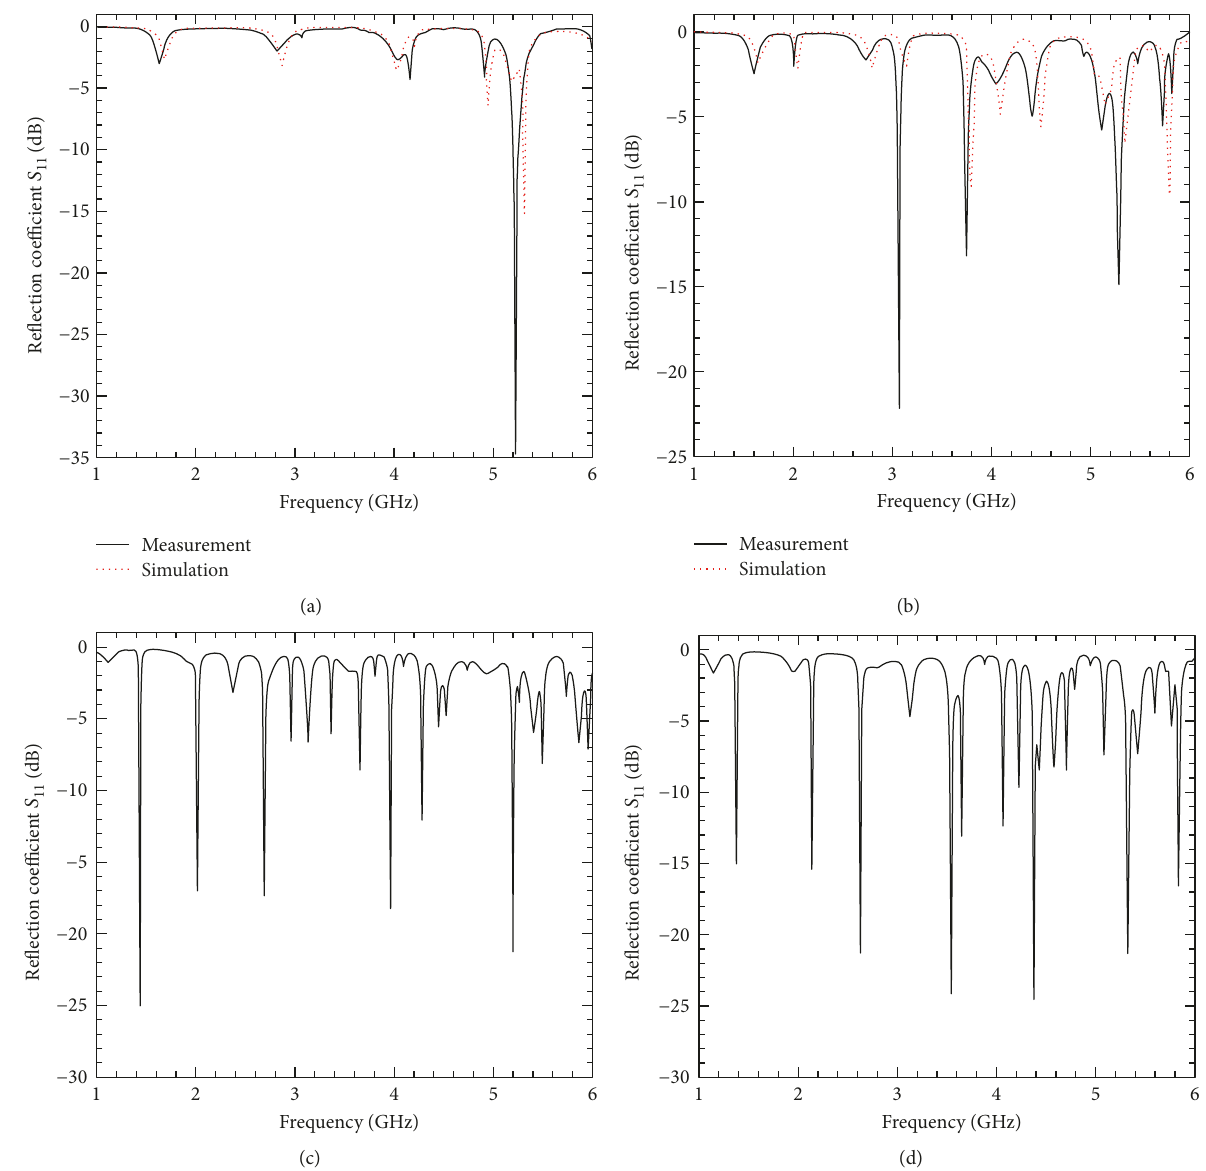
Figure 4: Simulated (red) and measured (black) re fl ection coe ffi cient S